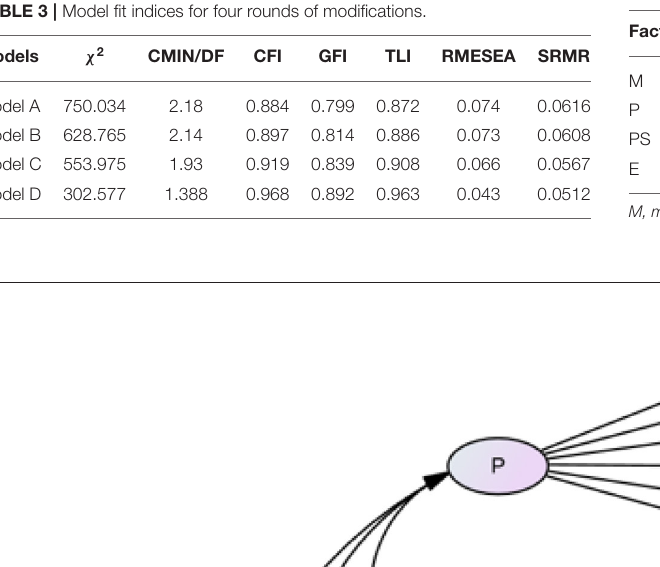
Frontiers in Psychology |